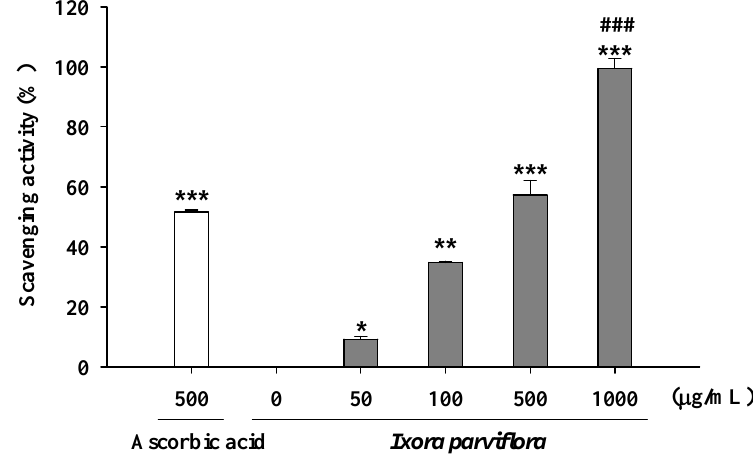
Figure 6. Scavenging hydrogen peroxide by IPE. (n = 4; significant difference versus control (without extract): * , P < 0.05; ** , P < 0.01; *** , P < 0.001; significant difference versus ascorbic: ### , P < 0.001).